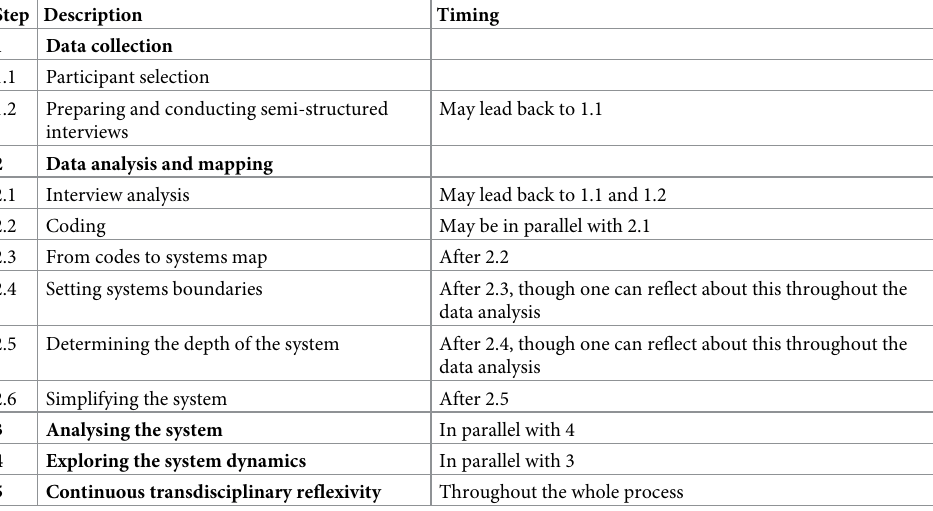
Table 1. Overview of the guideline and the timing of each step throughout the